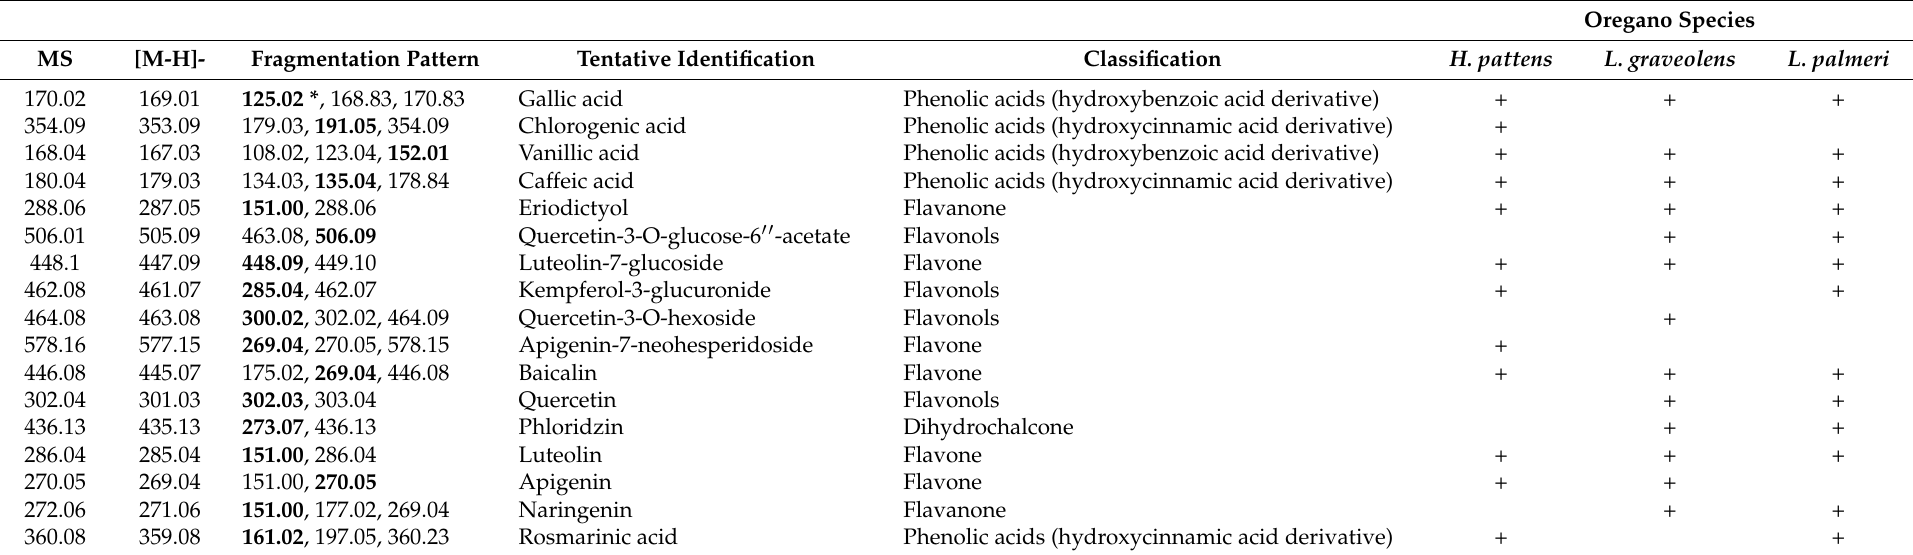
Table 2. Phenolic compounds identified in PRE of three oregano